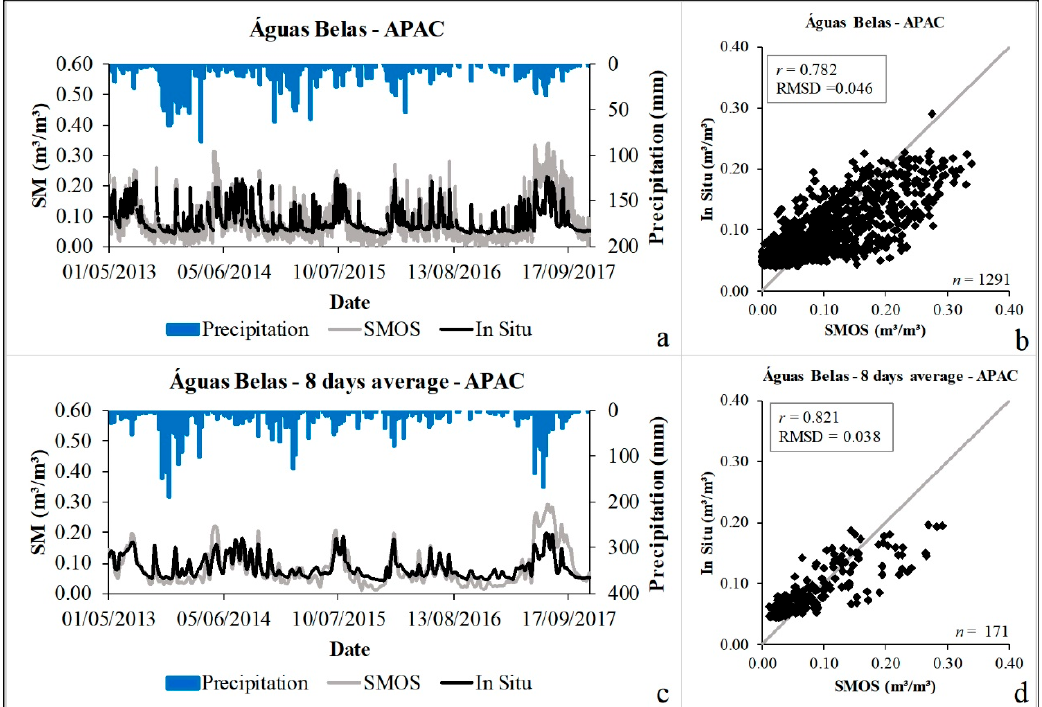
Figure 3. Águas Belas station (Water and Climate Pernambuco State Agency (APAC)): ( a ) daily time interval and ( c ) eight-day time interval. Scatter plot of the SMOS and in situ data for the ( b ) daily interval and ( d ) eight-day interval. SM = soil moisture. RMSD = root mean squared difference.